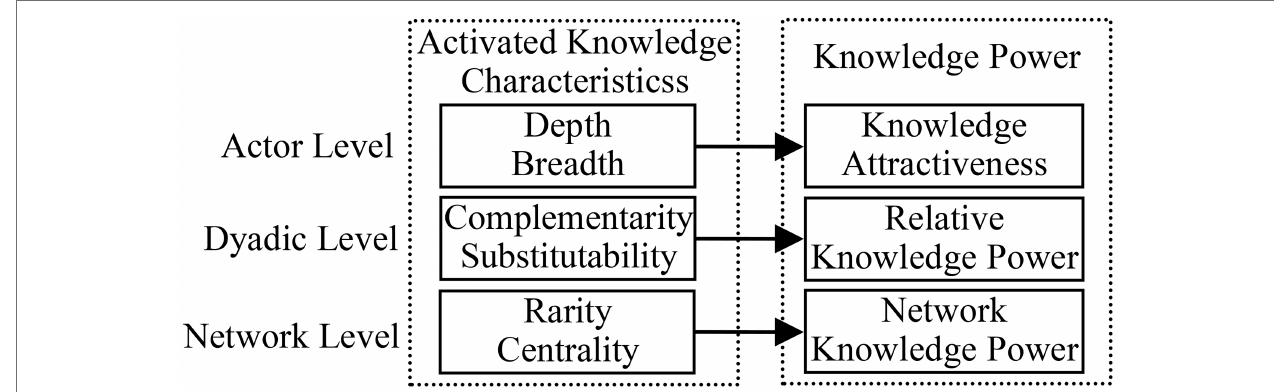
FIGURE 2 | The concept model of AKCs’ impact on knowledge